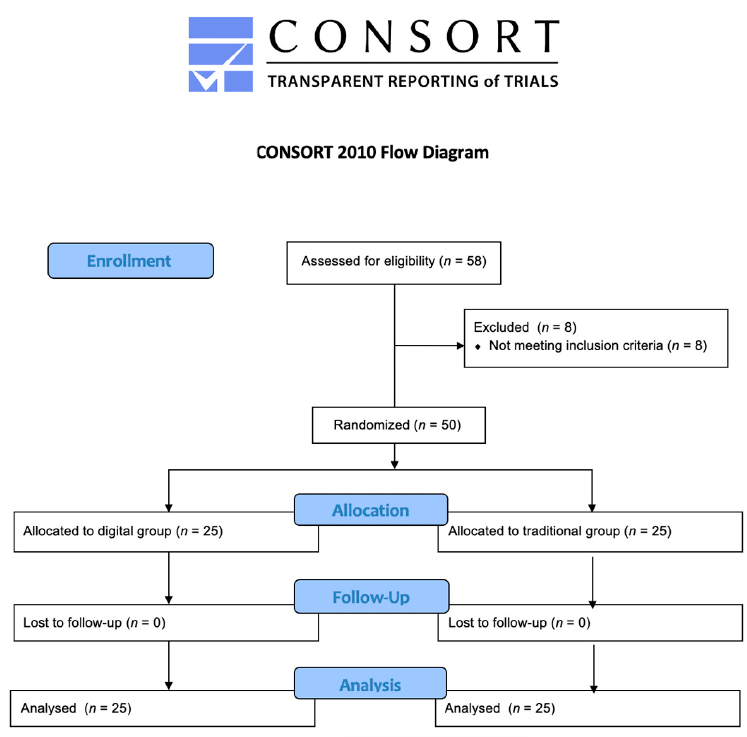
Figure A5. Consort flow diagram.